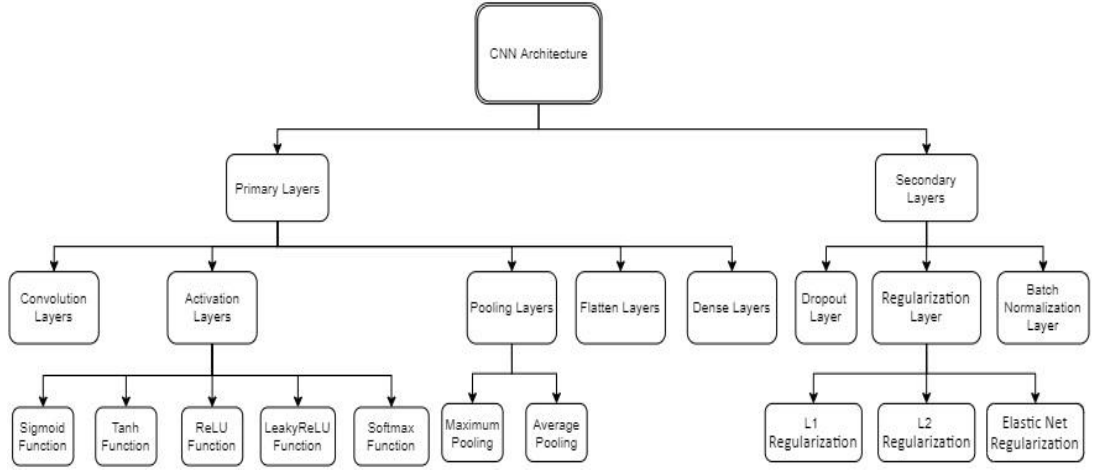
Figure 2. Convolutional neural network (CNN) structure.